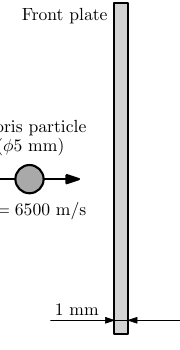
Figure 6. Standard Whipple shield